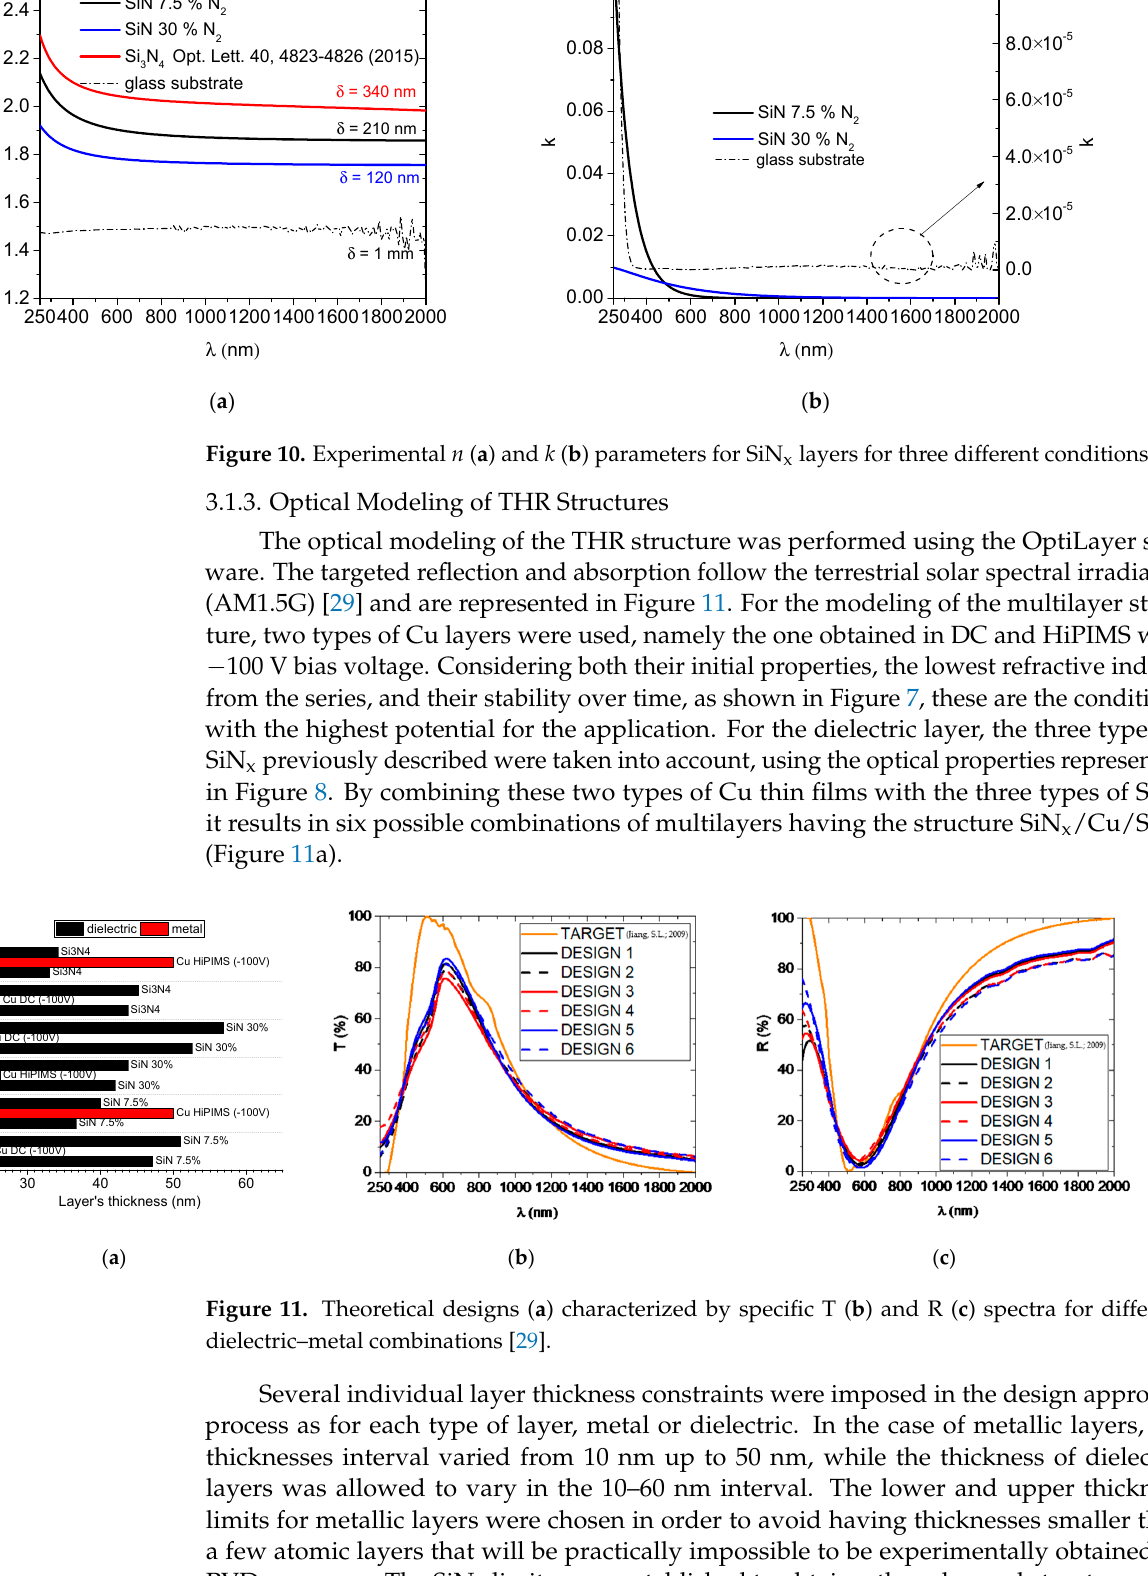
( b ) Figure 9. XRD patterns of copper thin films obtained by using DCMS ( a ) and HiPIMS ( b ) techniques at different substrate bias voltages. 3.1.2. SiN x Dielectric Layers The SiN x optical properties are highly dependent on the deposition conditions. In order to evaluate the potential of copper-based theoretical multilayer structures with THR properties, three types of layers were chosen as representative for very different optical properties achievable with SiN x thin films. Two of them were obtained experimentally in very different reactive conditions, namely low nitrogen content corresponding to 7.5% of N 2 flow from the total and 30% of N 2 flow from the total [27]. The third condition